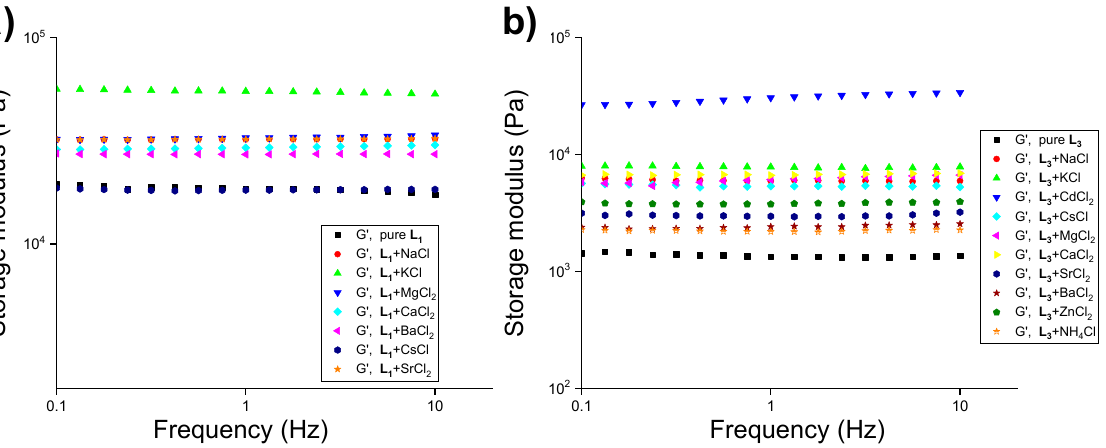
Figure 7. Frequency-sweep experiments with 1.5 wt% of the compound in the presence of various salts of chlorides (1.0 equiv.) in water at 20.0 °C with a constant strain of 0.02%, ( a ) L 1 (pure ligand at 1.8 wt%), and ( b ) L 3 (pure ligand at 1.8 wt%).